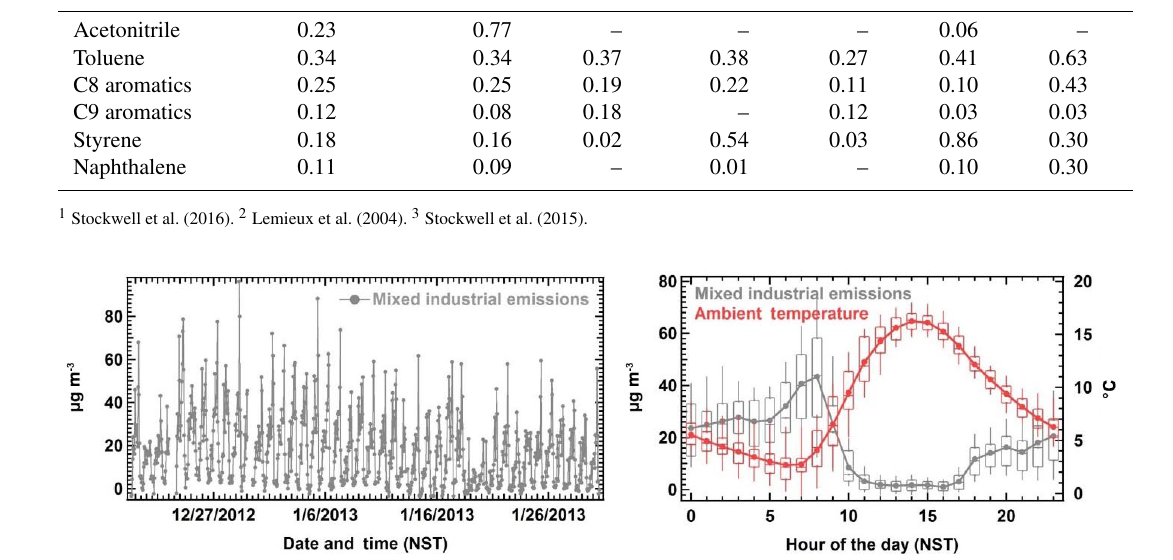
Figure 6. Time series and diel box and whisker plot for Factor 3 (mixed industrial emissions).